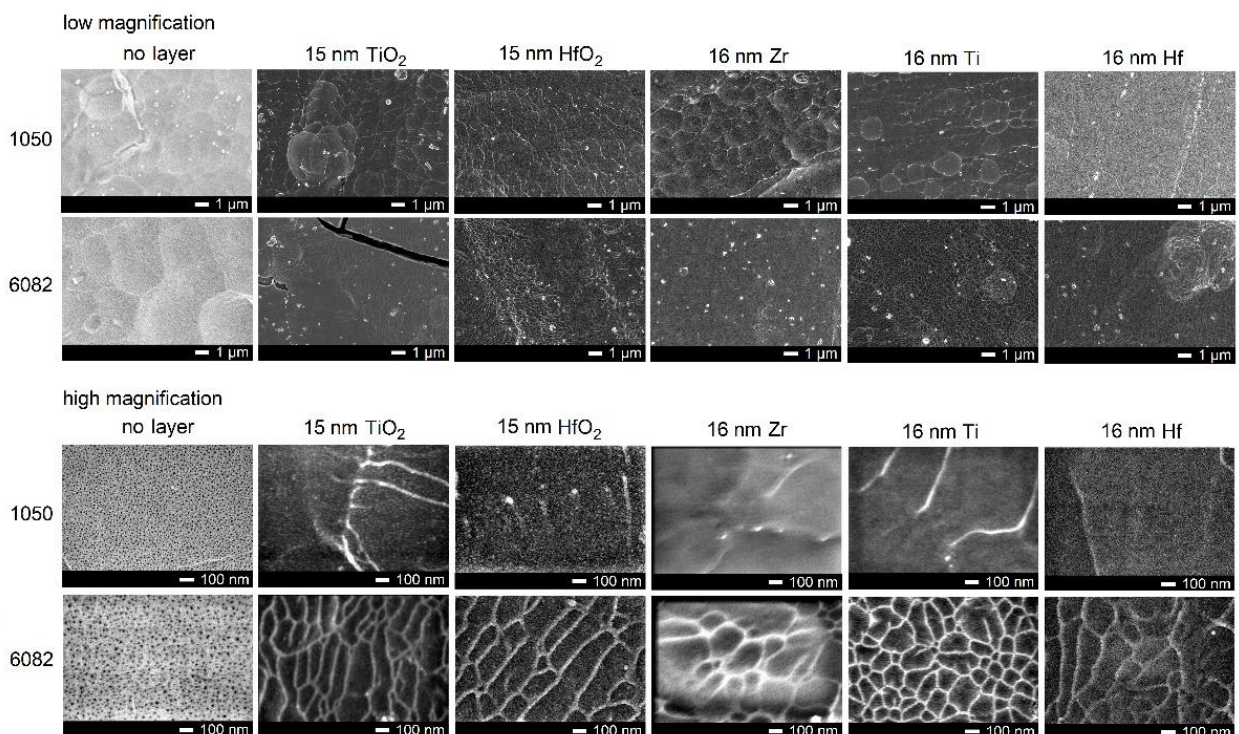
Figure 1. SEM images of anodic coatings with nanolayers of group IVB transition metals, deposited by ALD (15 nm) or sputtering (16 nm) under low ( top ) and high ( bottom ) magnifications. The high magnification images were adapted with permission from [18]. 2021, Elsevier.